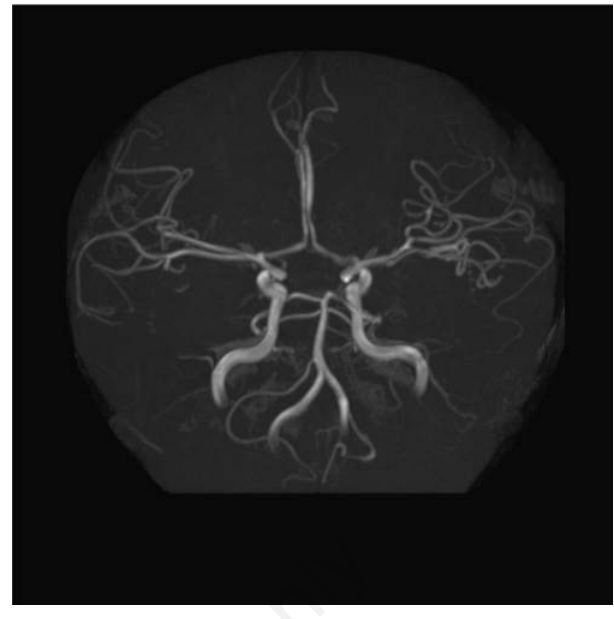
Figure 1. Magnetic resonance angiography (MRA) on day 17 of hospitalization (4 days after onset of headache). MRA shows seg- mental constriction (beaded appearance) of bilateral internal carotid arteries and bilateral anterior cerebral arteries (arrows).